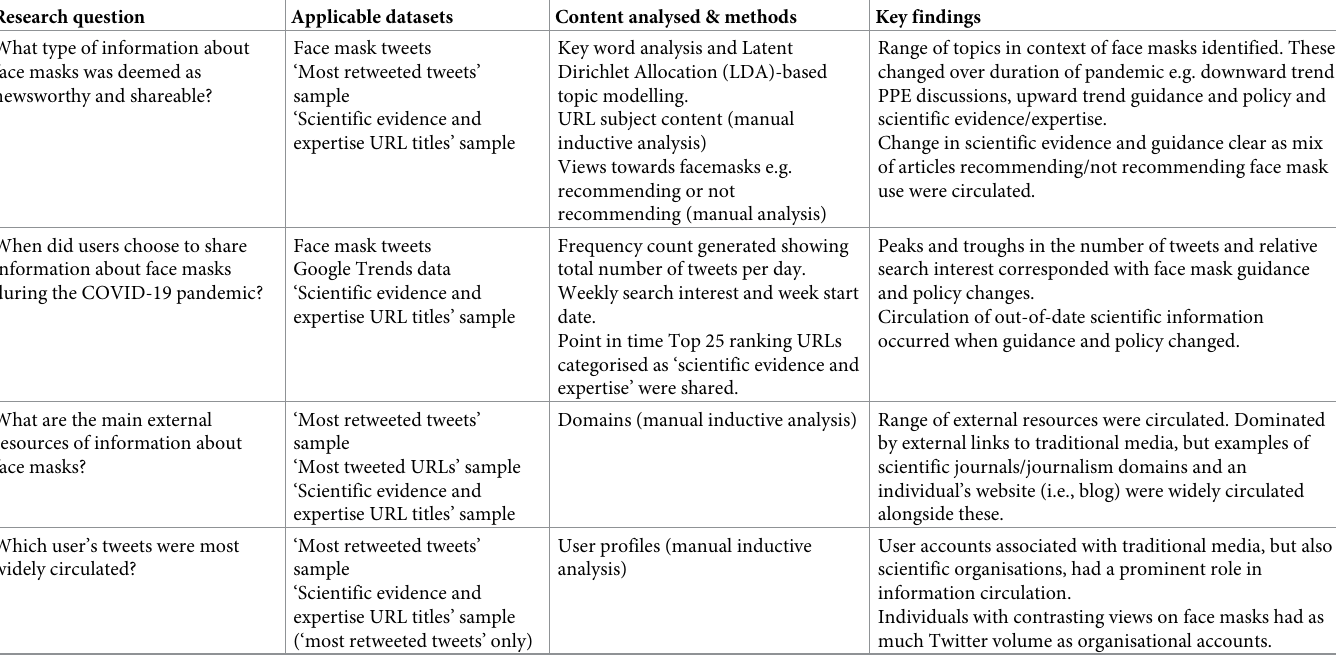
Table 9. Overview of research questions, applicable datasets, content analysed & methods and key